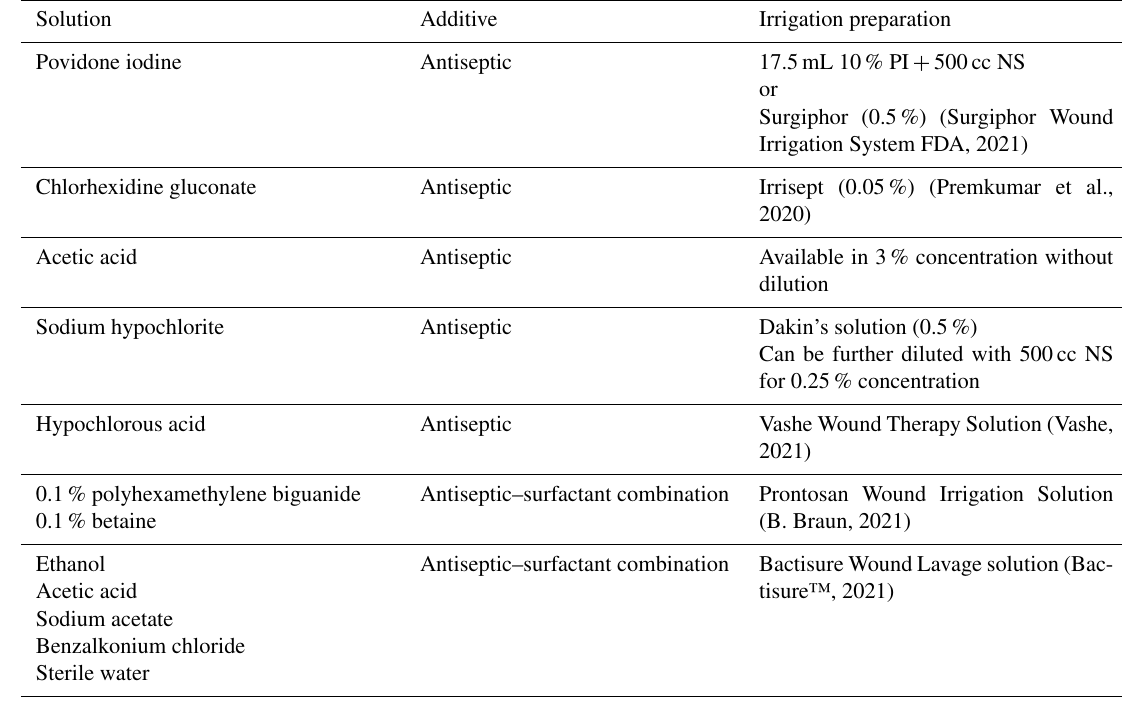
Table 2. Preparation of most common irrigation solutions.